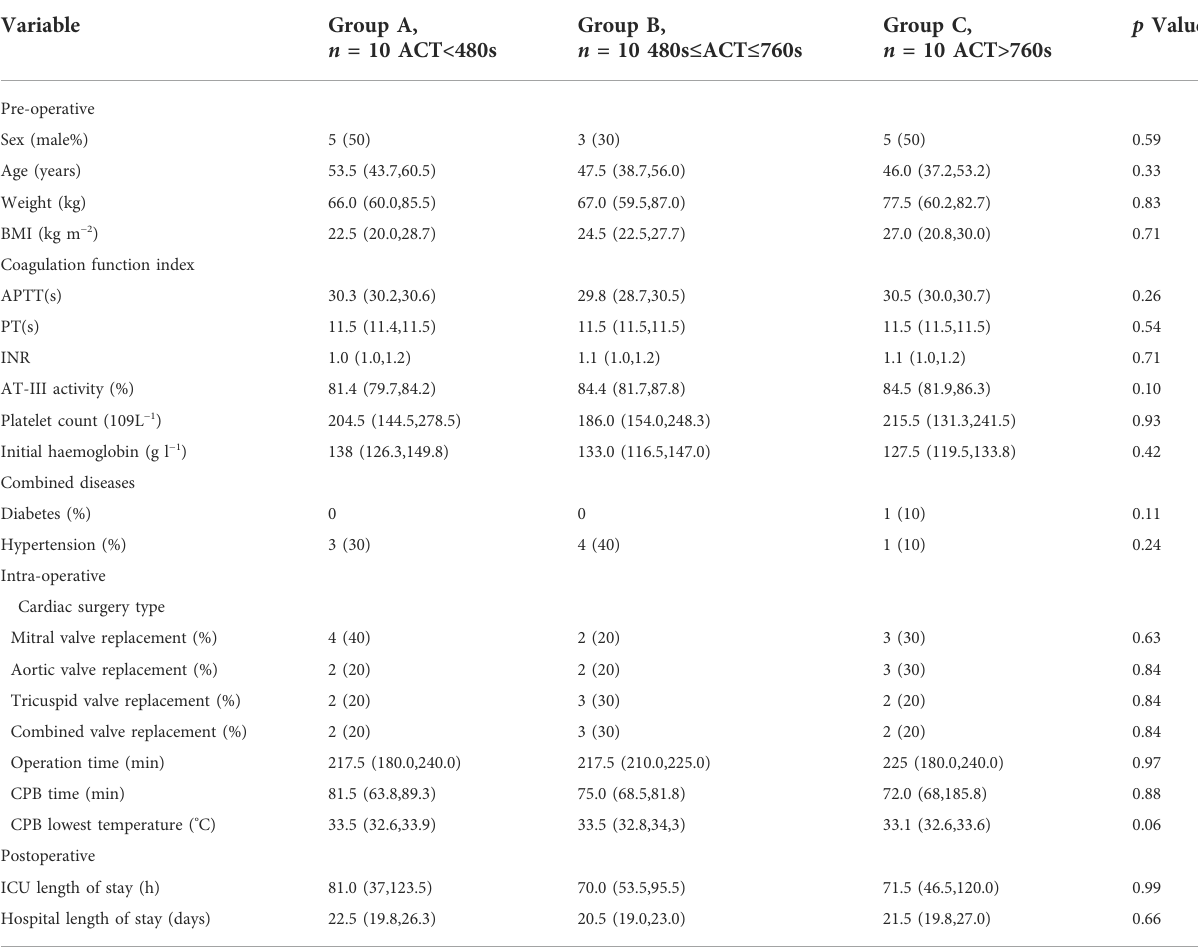
TABLE 3 Perioperation characteristics.